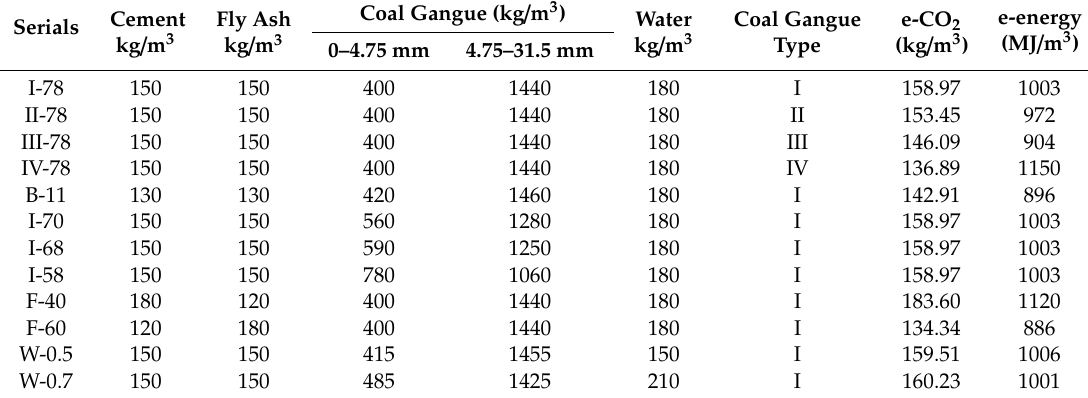
Table 2. Mix proportions for FGM